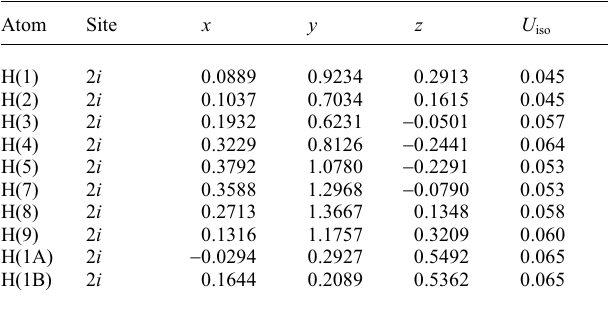
Table 2. Atomic coordinates and displacement parameters (in Å 2 )